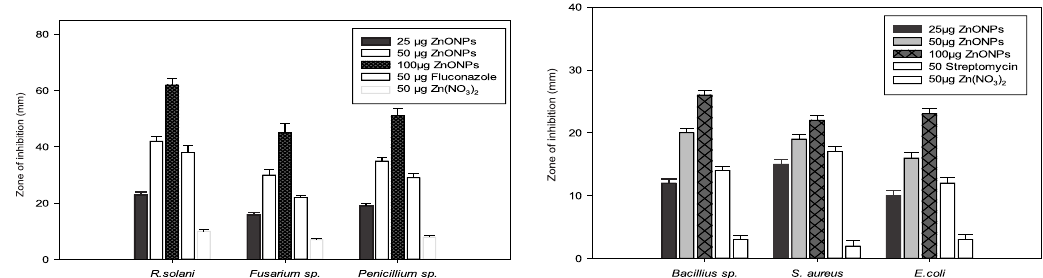
Fig. 9. (A) Evaluation of the antifungal activity of biogenic synthesized ZnONPs. (B) Evaluation of the bactericidal activity of biogenic synthesized